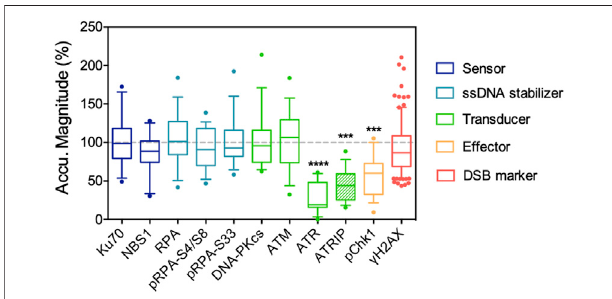
FIGURE 2 | Nuclear PI(4,5)P 2 sequestering by NLS-tagged PLC δ PH domain suppresses the recruitment of ATR/ATRIP complex following UVA laser microirradiation, and the accumulation of its downstream effector, phospho-S345 Chk1. The recruitment of ATM, DNA-PKcs and other DNA repair proteins listed here are not affected. The data is adapted with permission from (Wang et al.,